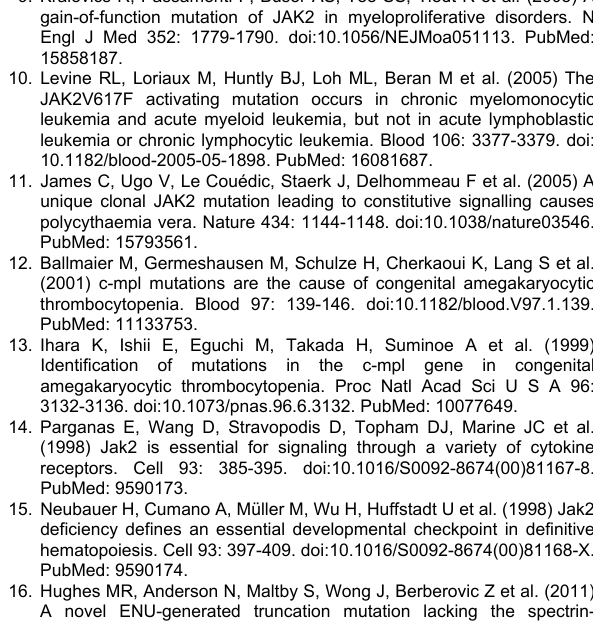
Figure S2. Functional loss of Jak2 in Jak2 K915X/- and Jak2 +/- does not disrupt CFU-C frequency in the bone barrow or spleen. (A) Total CFU-C frequency in the bone marrow. (B) The frequency of CFU-C in the spleen. (C) CFU-C differential count of bone marrow derived colonies included: CFU-G (granulocyte), CFU-M (monocyte), CFU-GEMM (granulocyte, erythrocyte, (granulocyte and monocyte) and BFU-E (erythroid). (D) Splenic CFU-C differential. All CFU-C were derived from Jak2 K915X/- and Jak2 +/- and littermate controls at 12-14wks of age. Data are presented as ± SEM; n=5-8.